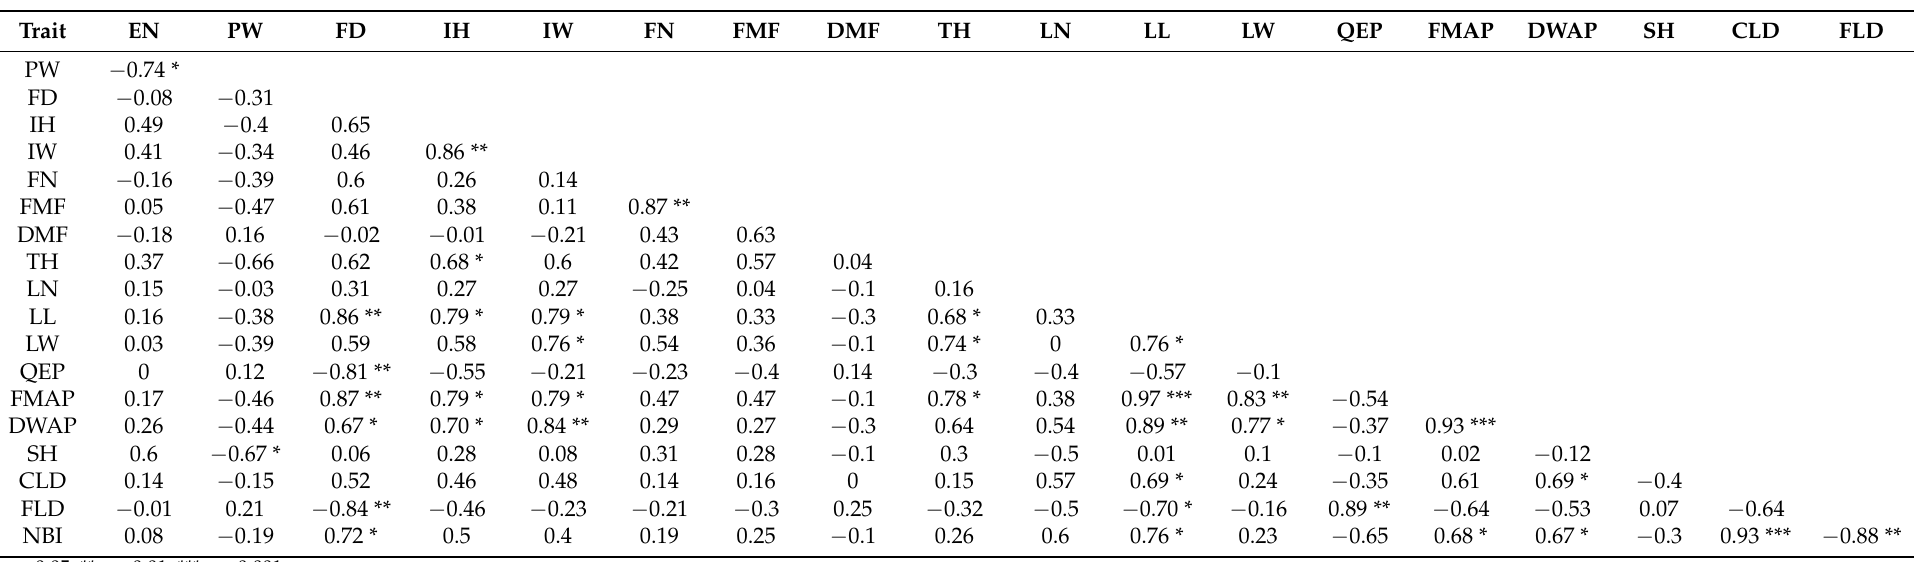
Table 6. Correlation coefficients between observed